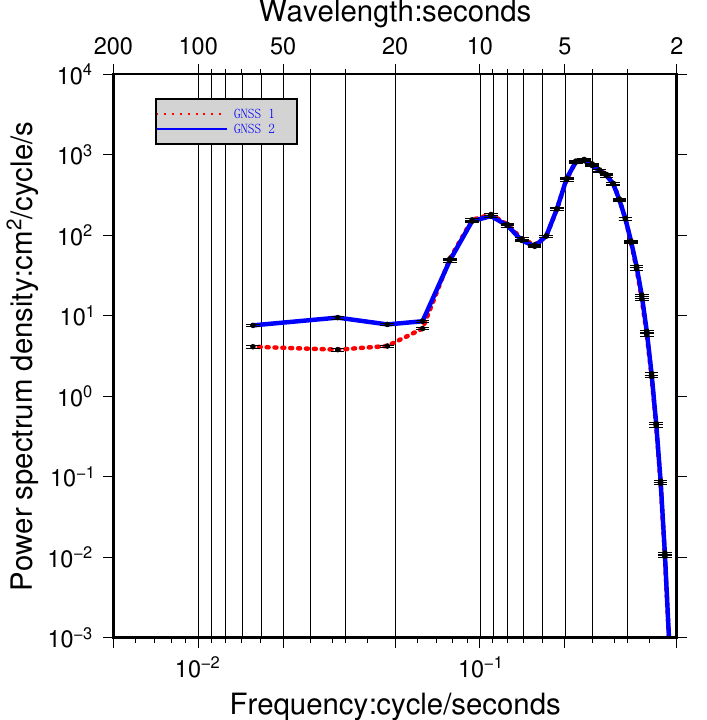
Figure A1. The PSD of the band-pass filtered WSSE of the two GNSS buoys at the same location. Red (blue) line represents GNSS buoy 1